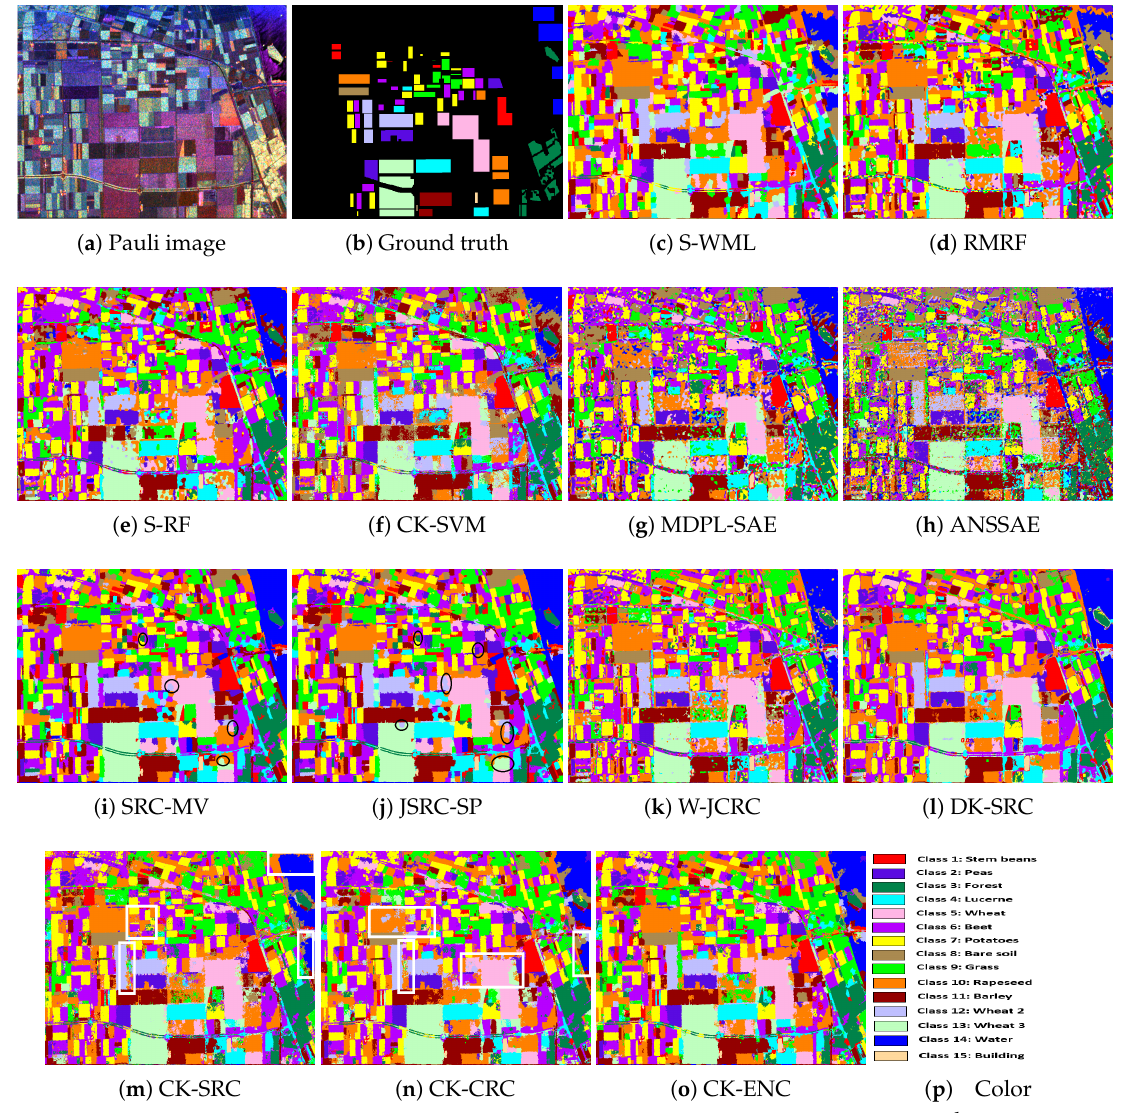
Figure 8. Classification results of the Flevoland dataset with different